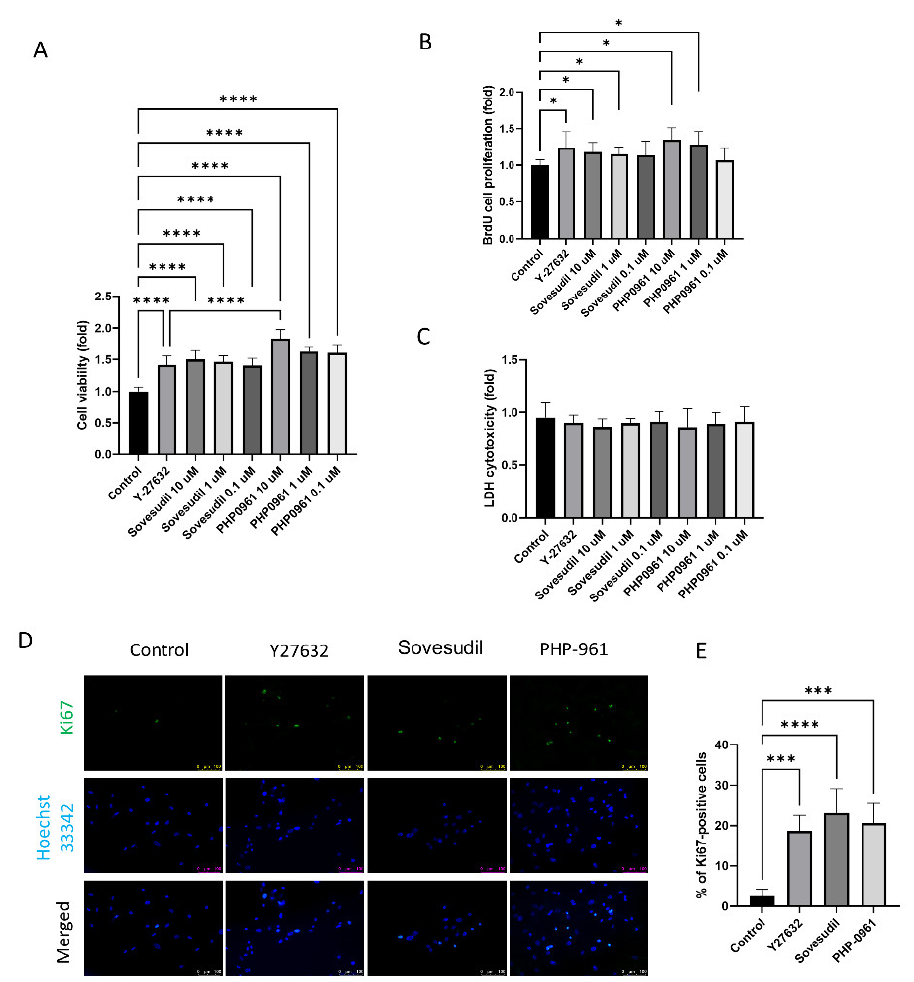
Figure 1. Cell proliferation and cell cytotoxicity. ( A , B ) Cell viability and BrdU cell proliferation rate were evaluated by CCK-8. ( C ) Cytotoxicity was measured by the LDH cytotoxicity test. ( D , E ) Cell proliferation evaluated by immunofluorescence staining of Ki67, a proliferation marker. * p < 0.05, *** p < 0.001 and **** p < 0.0001.